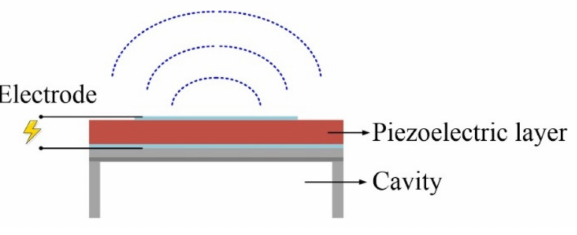
Figure 1. Structure of the pMUT device.